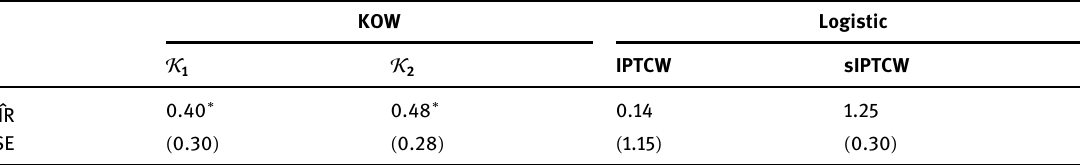
Table 1: E ff ect of HIV treatment on time to